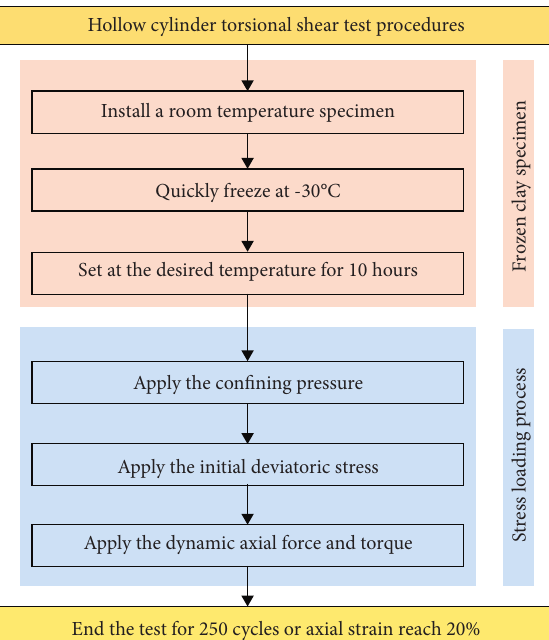
Figure 5: The operating procedures of hollow cylinder torsional shear